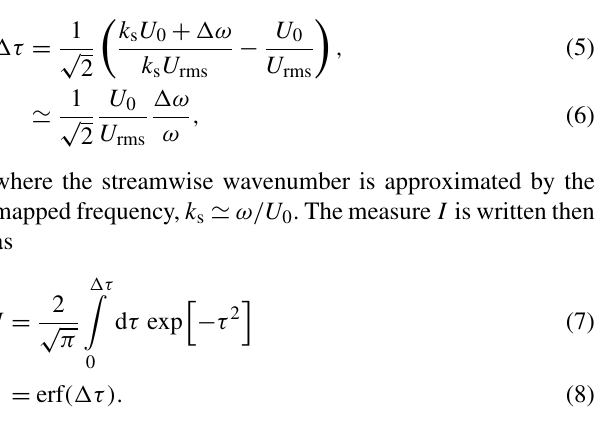
Figure 1. Sketches of wavenumber–frequency spectra for a good case of Taylor’s hypothesis with a small sweeping velocity (upper panel) and a bad case with a large sweeping velocity (lower